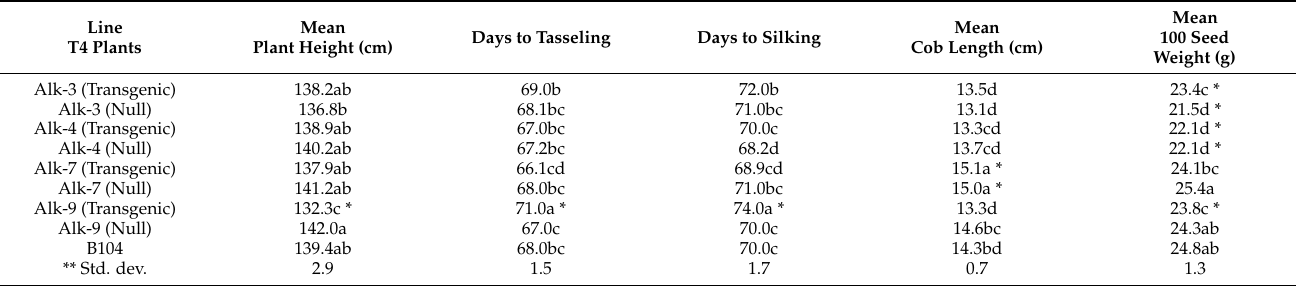
Table 4. Phenotypic assessment of homozygous Alk-RNAi lines in comparison to the controls. Line T4